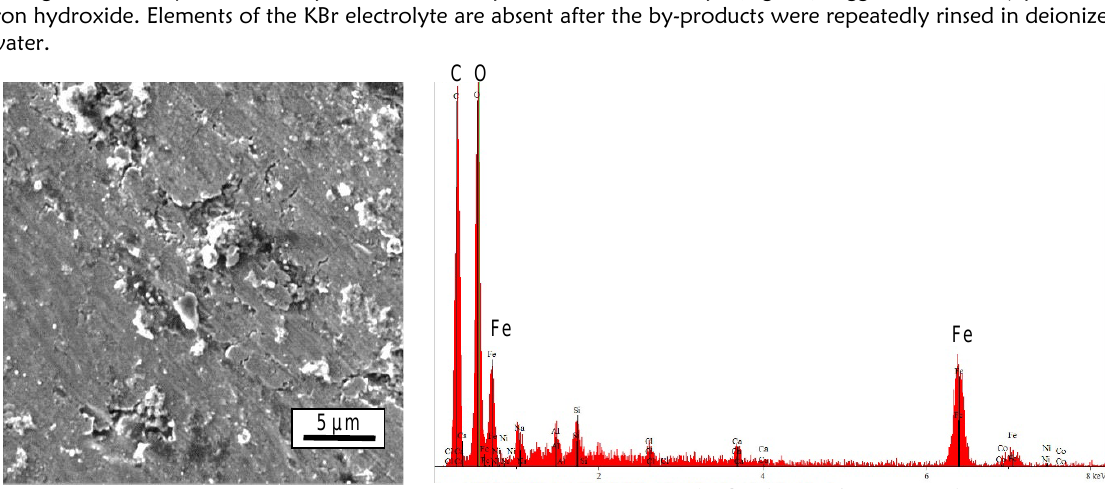
Figure 9: EDX spectrum of ECM by-products on carbon tape. Iron, Figure 8: SEM image of dried ECM by- carbon, and oxygen are dominating elements. products on a titanium plate.